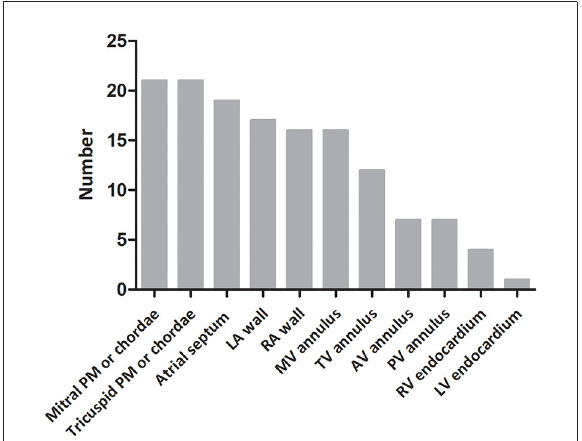
FIGURE1 Conditions related to mothers carrying anti-Ro and anti-La antibodies. SLE, systemic lupus erythematosus; UAD, undifferentiated autoimmune disease; pSS, primary Sjögren syndrome; RA, rheumatoid arthritis; aSS, Sjögren syndrome associated with other systemic autoimmune diseases.